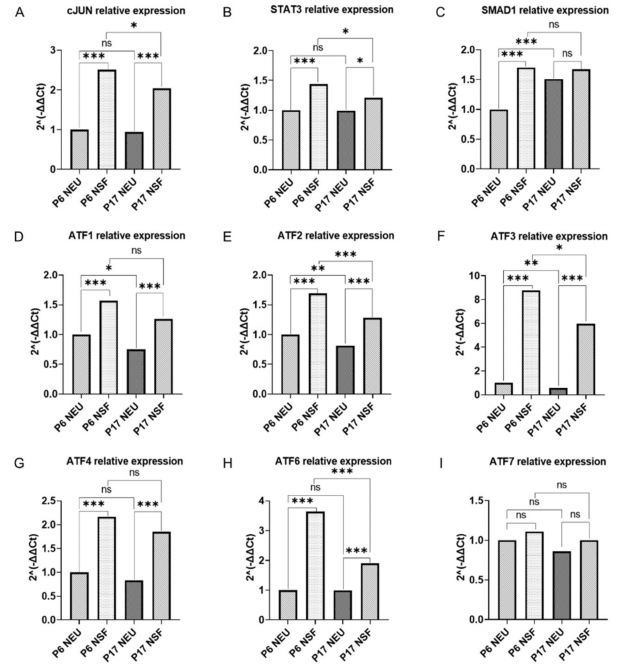
Figure 1. Difference in RAG and ATF gene expression in neurons versus neurospheres. Difference in gene expression between P6 and P17 neurons (NEU) and neurospheres (NSF) was measured by RT-qPCR, normalized to GAPDH mRNA levels, and shown as fold difference compared to P5–6 neurons mRNA levels. mRNA was obtained from cortical neurons, and neurospheres at DIV7 derived from opossums P5-6 and P16-17 from at least three independent experiments. Regeneration- associated genes ( A – C ), activating transcription factors ( D – I ). The accepted level of significance was p < 0.05. p < 0.001 very significant ***, 0.001–0.01 very significant **, 0.01–0.05 significant *, ≥ 0.05 not significant (ns). For statistical significance and tests performed, see Supplementary Figure